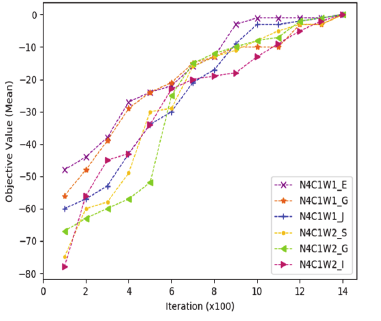
Fig. 11. Convergence of Version 1 Fig. 12. Convergence of Version 2